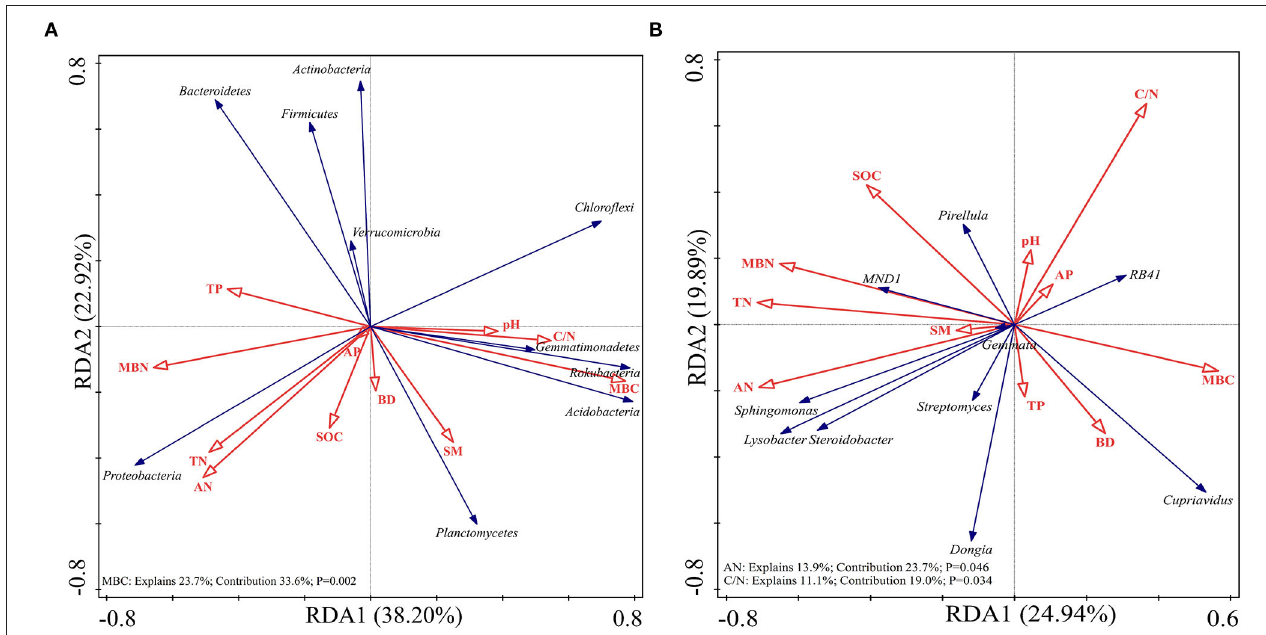
FIGURE 7 | Redundancy analysis (RDA) of soil-dominant bacteria phyla (A) and soil-dominant bacteria genus (B) constrained by soil